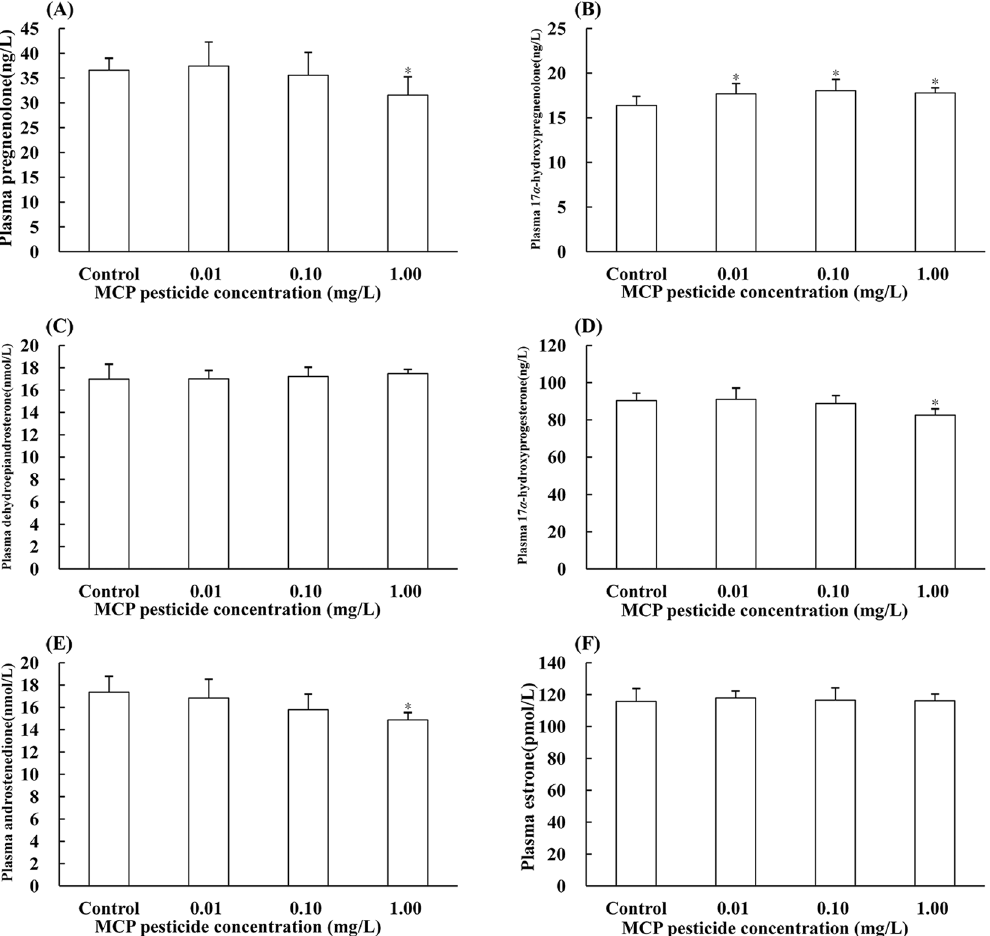
Figure 4. Effects of MCP pesticide on plasma content of intermediate hormones in male goldfish ( Carassius auratus